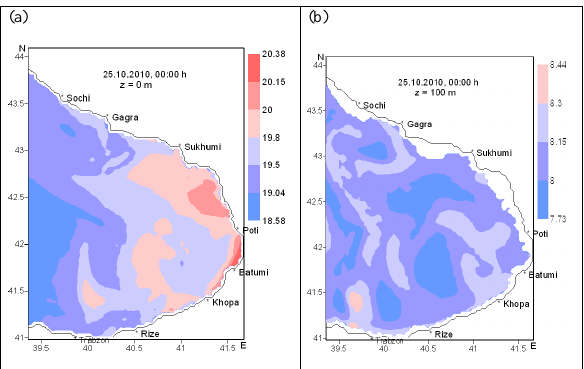
Fig. 12. Temperature field (deg. C) at 25.10.2010, 00:00 h on depths of 0 m (a) and 100 m (b).